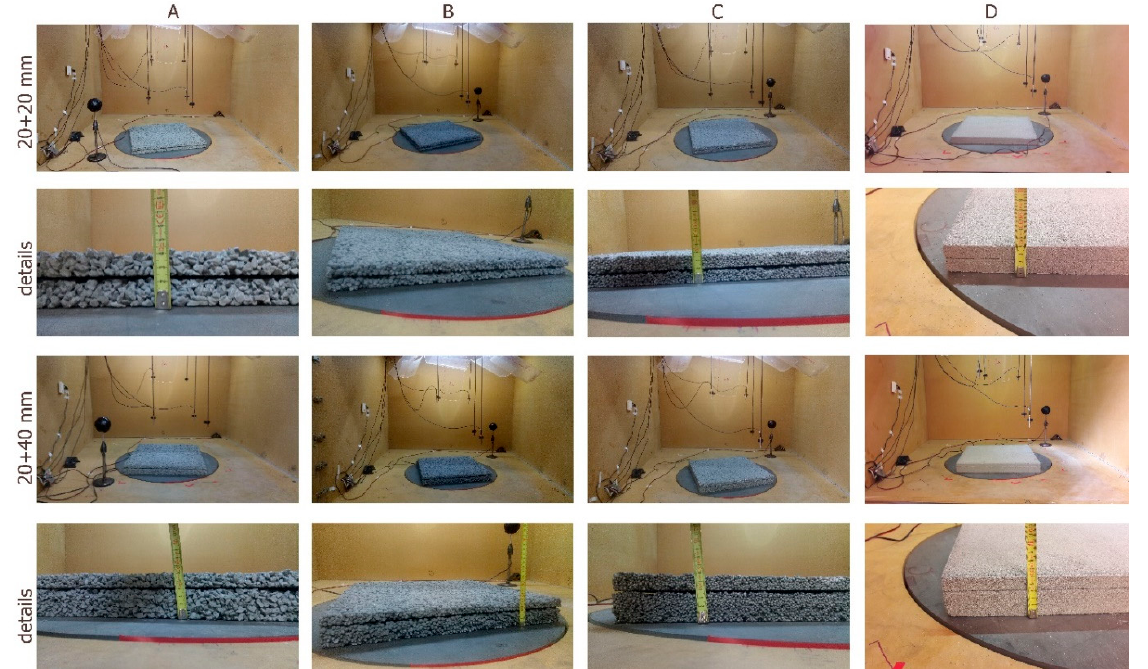
Figure 2. Multiple layers of 20 + 20 mm and 20 + 40 mm. Sample ( A ): crushed normal weight aggregates 4–8 mm; Sample ( B ): round lightweight aggregates 4–8 mm; Sample ( C ): round lightweight aggregates 2–4 mm; Sample ( D ): round lightweight aggregates 0.5–1